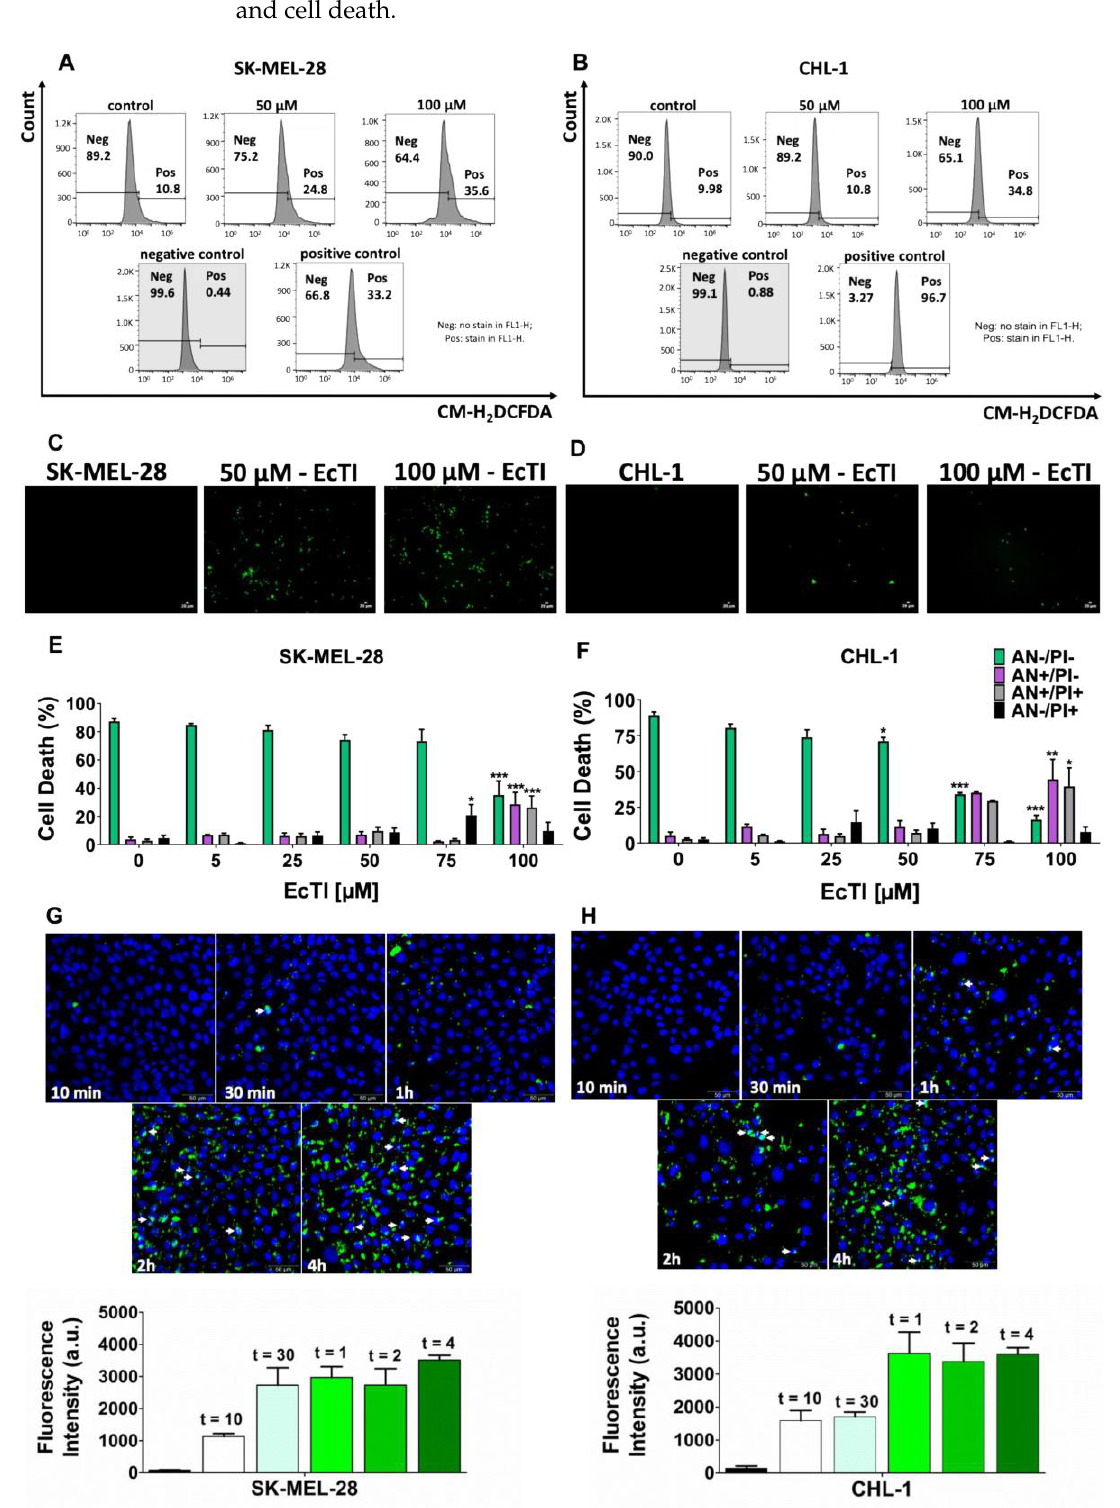
Figure 4. ROS production, caspase-3/7 activity, cell death, and EcTI internalization. Intracellular reactive oxygen species (ROS) were measured using 2,7-dichlorodihydrofluorescein